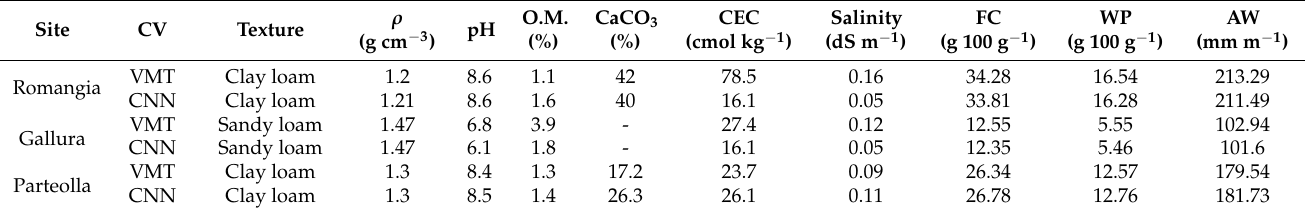
Table A1. Soil physical and chemical analysis and hydraulic